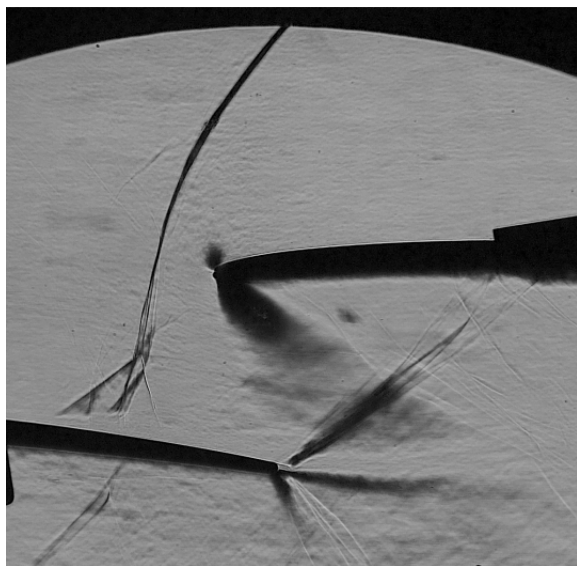
Figure 3. Unstarted supersonic flow field.